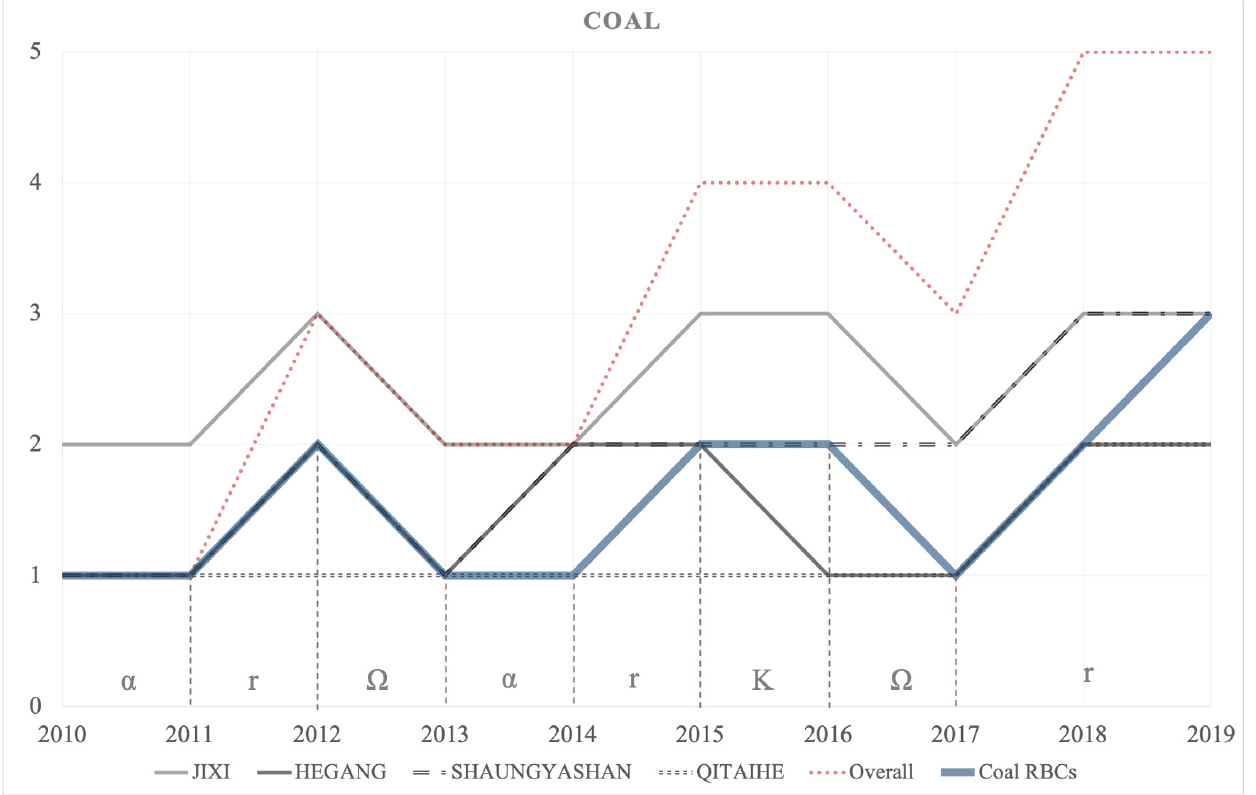
Figure 11. Resilience dynamics of coal-based cities from 2010 to 2019.